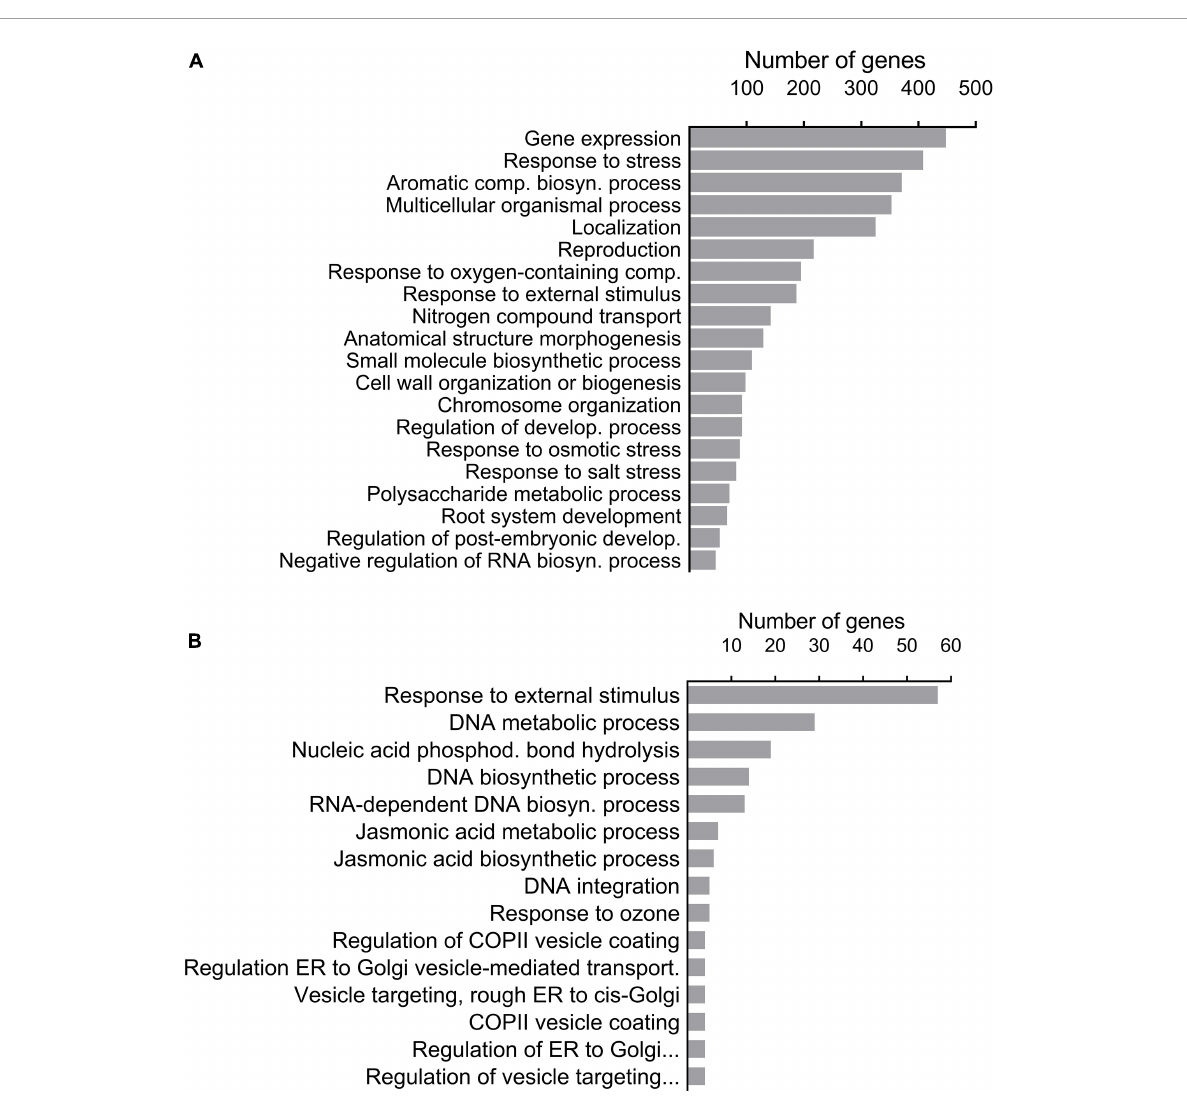
genes belonged to the biosynthesis of secondary